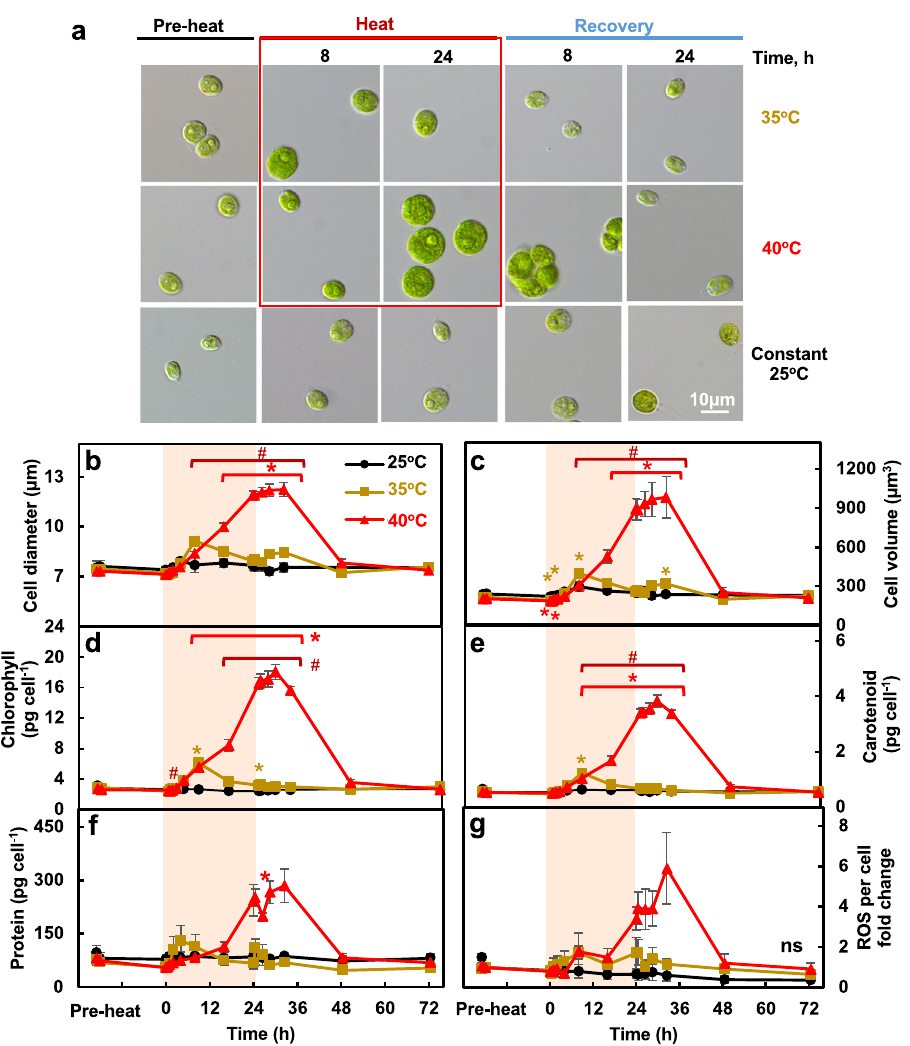
Fig. 5 Heat of 40°C persistently increased cell size, cellular levels of pigments, and proteins while these effects were transient with 35°C heat. a Light microscopic images of Chlamydomonas cells. b , c Cell diameters and volume determined using a Coulter Counter. d – f Total chlorophyll, carotenoid, protein content per cell. g Fold-change of reactive oxygen species (ROS) levels per cell quanti fi ed using CM-H2DCFDA ROS indicator. Mean ± SE, n = 3 biological replicates. Black, brown and red curves represent experiments with constant 25°C, treatments of 35°C or 40°C respectively. Red shaded areas depict the duration of high temperature. Statistical analyses were performed using two-tailed t-test assuming unequal variance by comparing treated samples with 25°C at the same time point (*, p < 0.05) or between 35°C and 40°C at the same time point (#, p < 0.05). b – g P values were corrected by FDR. The colors and positions of asterisks (*) match the treatment conditions and time points, respectively. The positions of pound signs (#) match the time points. (g) Not signi fi cant, ns, p > 0.05 after FDR